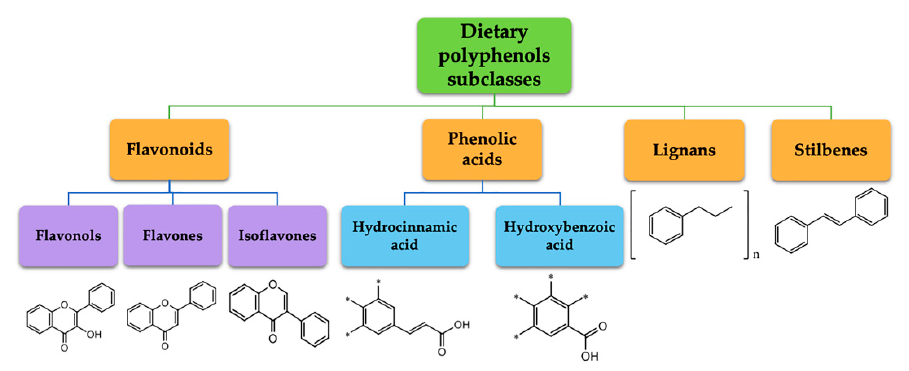
Figure 1. Dietary polyphenols known subclasses scheme.